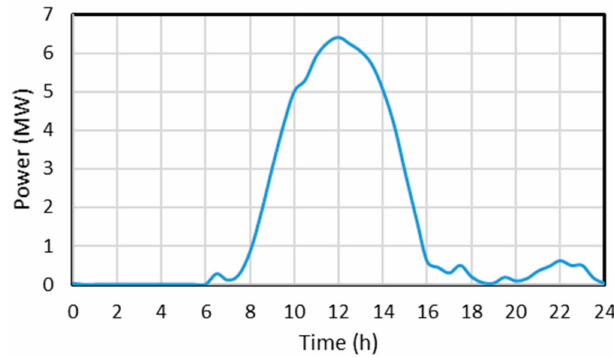
Figure 9. Aggregated power export from the participating households after the implementation of DR for scenario 2 (summer, DR adoption level of 40%, EV adoption level of 10%).